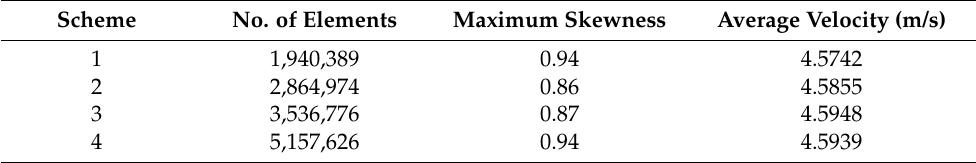
Table 1. Grid independency